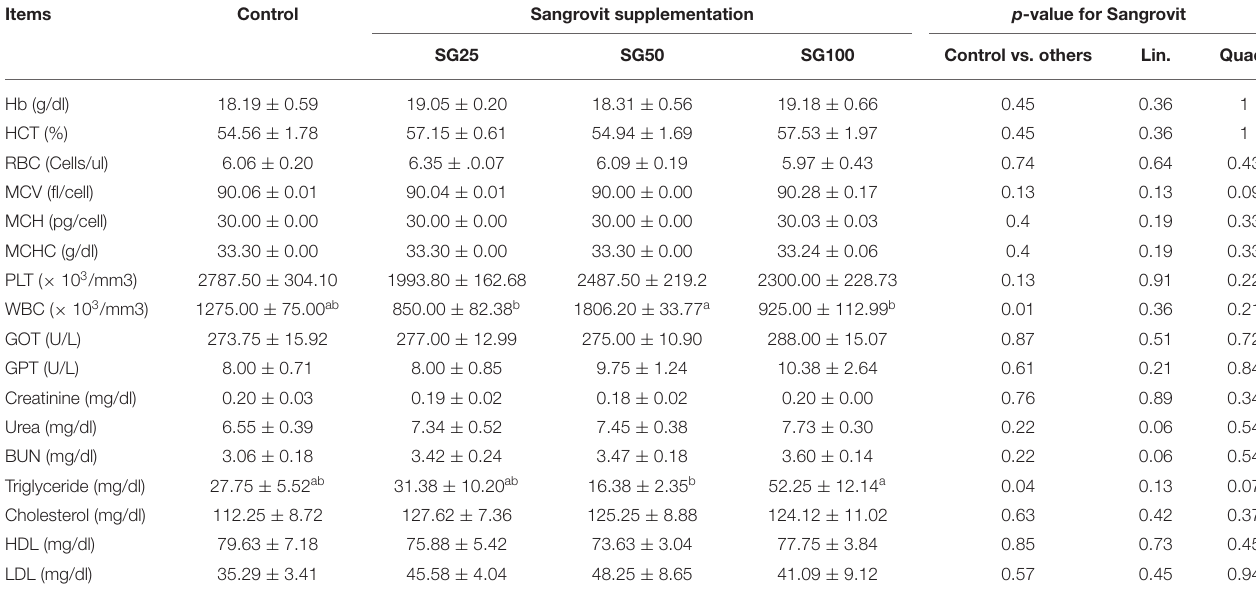
TABLE 4 | Effect of Macleaya cordata dietary supplementation on hematological and biochemical parameters of turkey at the 2 nd week of age. Items Control